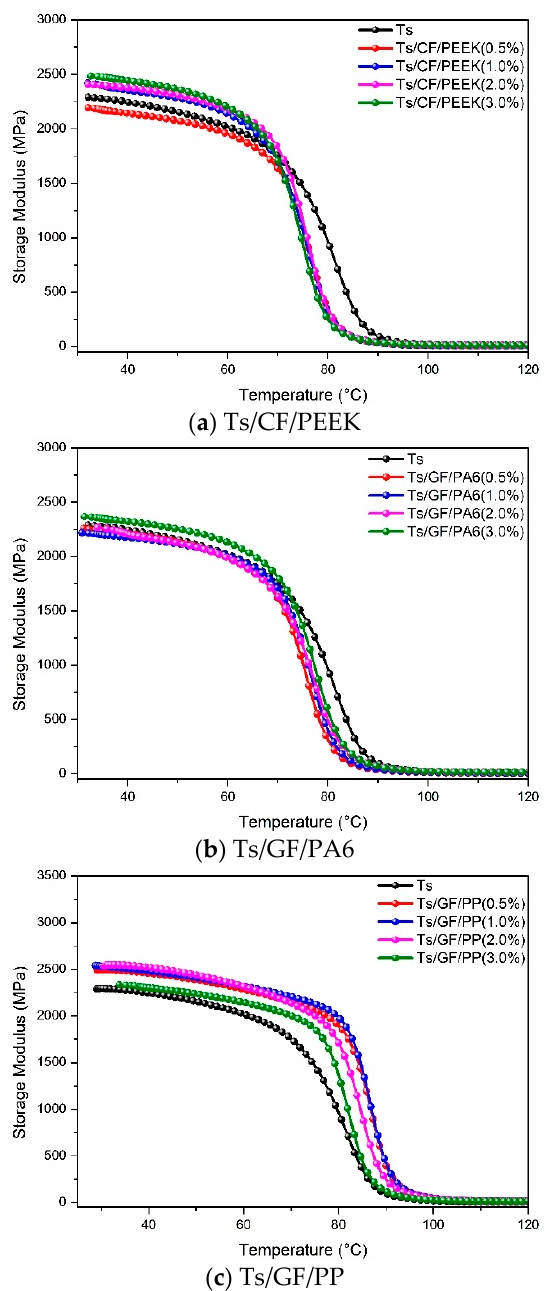
Figure 12. Effects of thermoplastic composite fillers on storage modulus of Ts resin of ( a ) Ts/CF/PEEK, ( b ) Ts/GF/PA6 and ( c ) Ts/GF/PP.